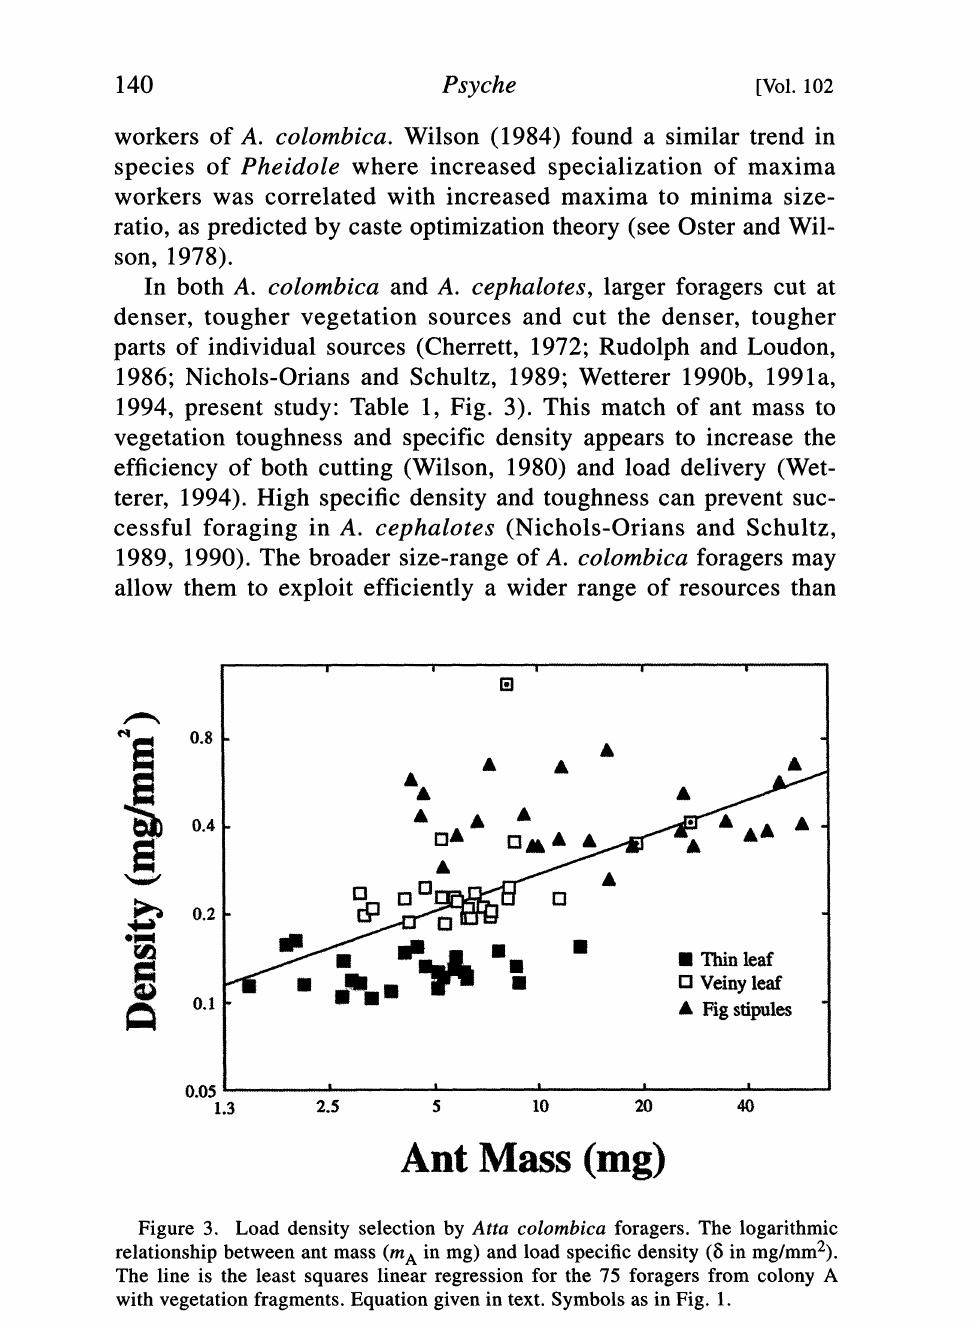
Figure 3. Load density selection by Atta colombica foragers. The logarithmic relationship between ant mass (m A in mg) and load specific density (5 in mg/mm2). The line is the least squares linear regression for the 75 foragers from colony A with vegetation fragments. Equation given in text. Symbols as in Fig.